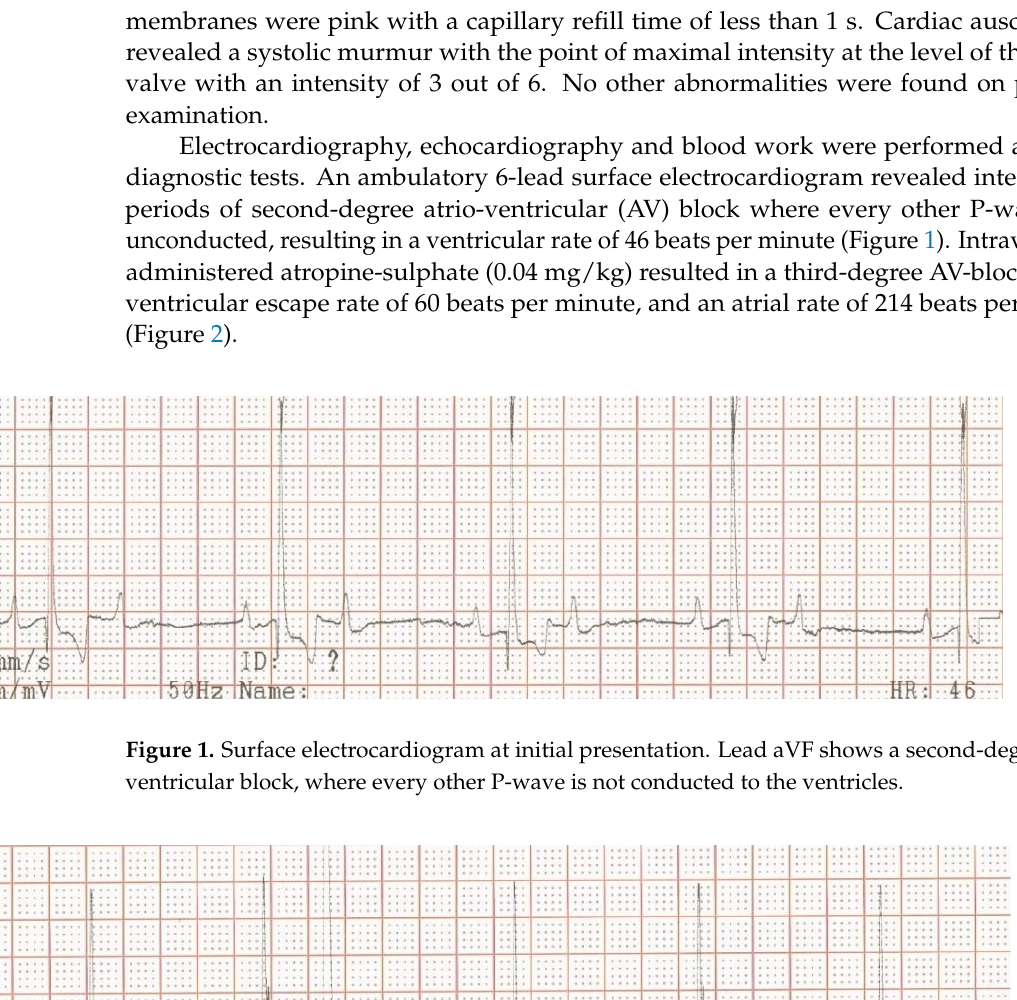
Figure 2. Surface electrocardiogram after intravenous injection of atropine (0.04 mg/kg). Lead aVF shows third-degree atrio-ventricular block with presumed nodal escape beats and a solitary ventricular premature complex. The atrial rate is markedly, and the ventricular rate is mildly increased compared to the pre-atropine situation (Figure 1).